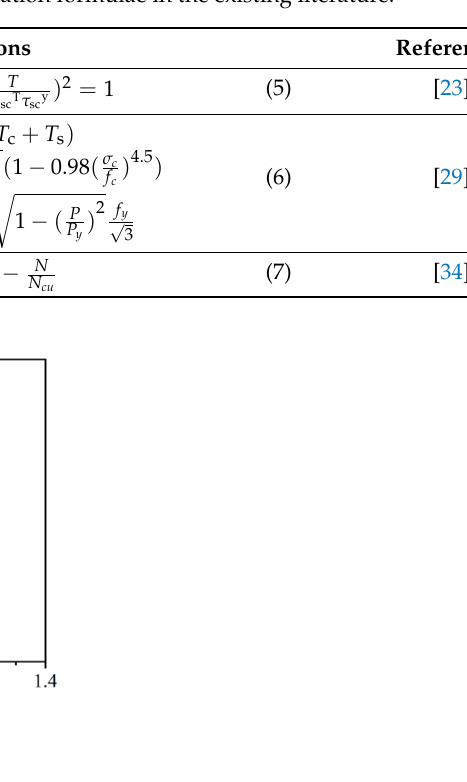
Table 2. The ultimate bearing capacity calculation formulae in the existing literature.